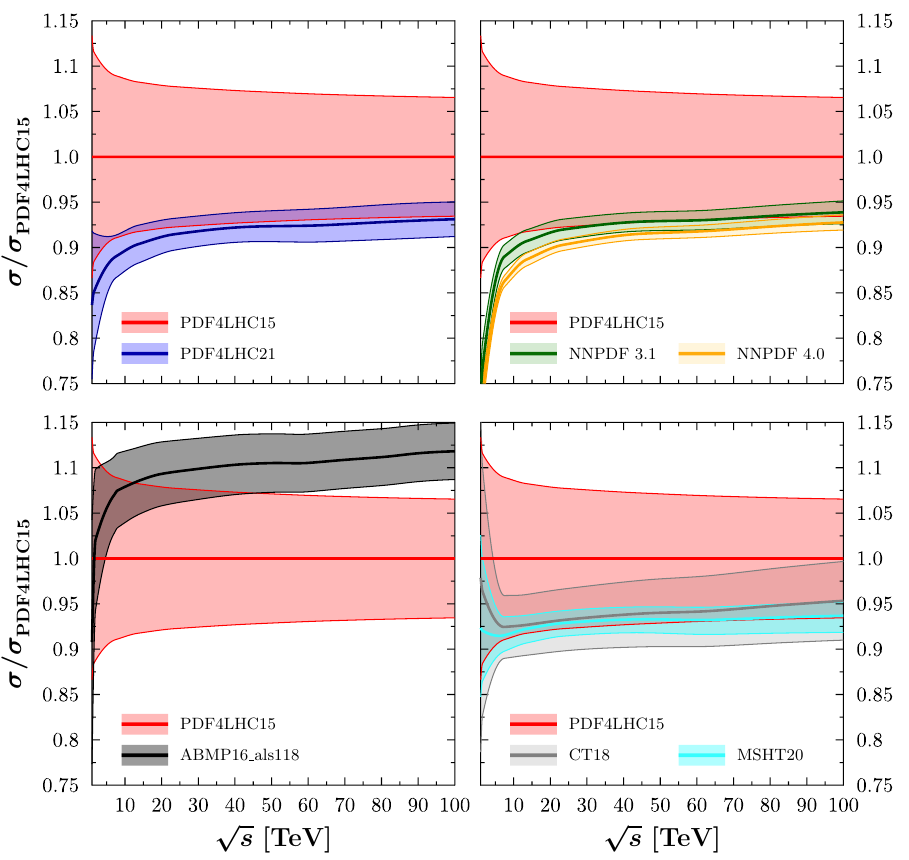
Figure 11 . Same as in figure 10, but for bottom-quark-fusion Higgs production in the five-flavor-